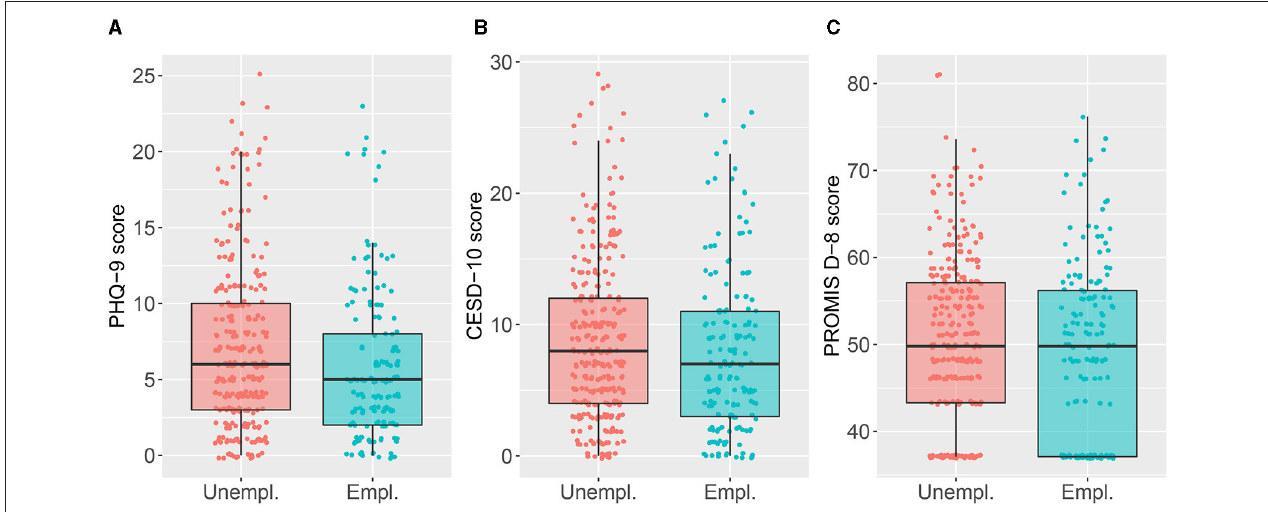
FIGURE 1 | Boxplot of the scores for employed and unemployed subjects on three questionnaires measuring depression: A , the Patient Health Questionnaire-9 (PHQ-9, scale [0, 27]), B , the Center for Epidemiological Studies Depression Scale-10 (CESD-10, scale [0, 30]) and, C , the eight-item PROMIS Depression Short Form (PROMIS D-8, scores reported on a standardized scale with mean 50 and standard deviation 10). Higher scores indicate more symptoms of